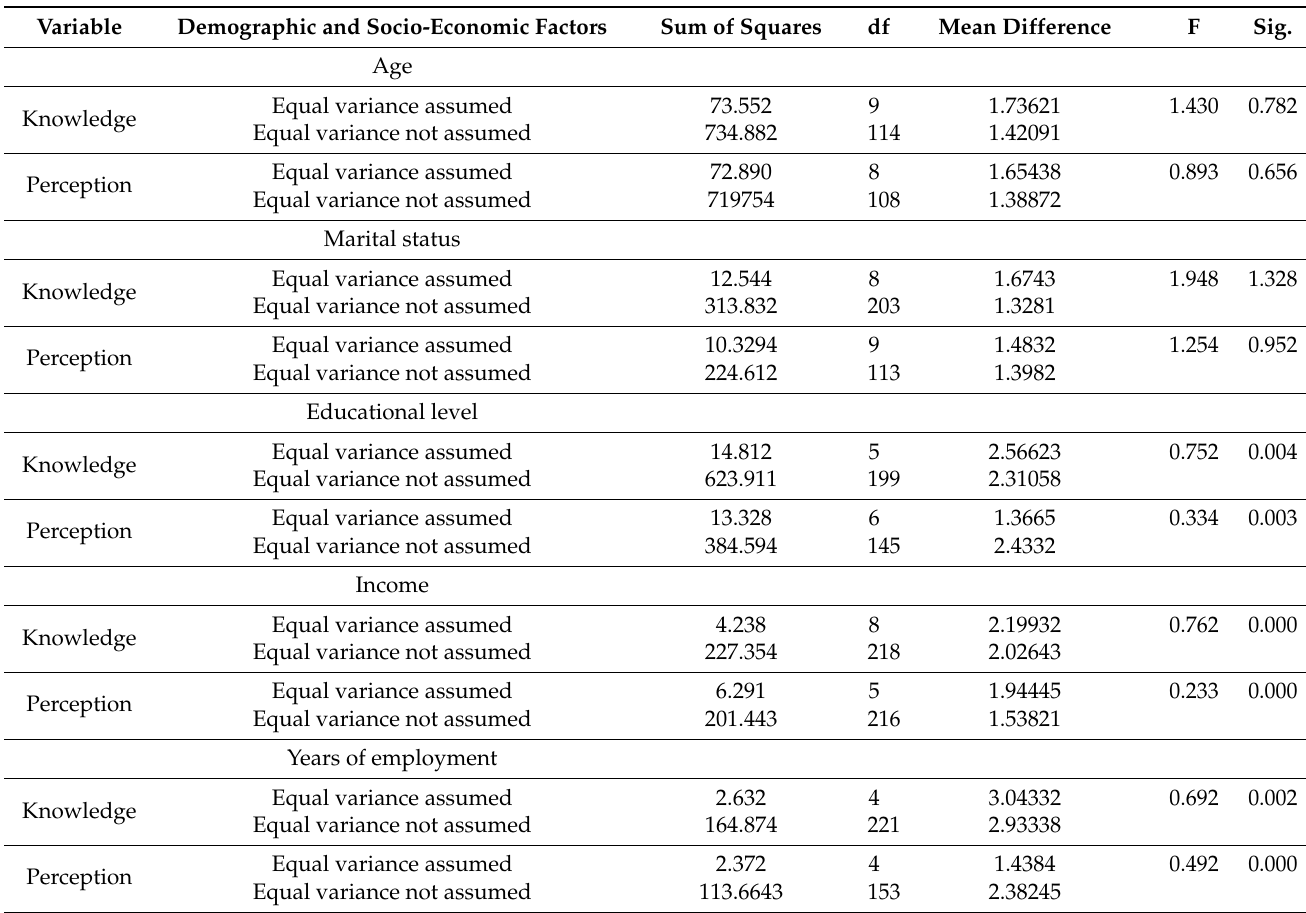
Table 7. ANOVA results on knowledge and perception to participate in e-waste management according to demographic and social factors.